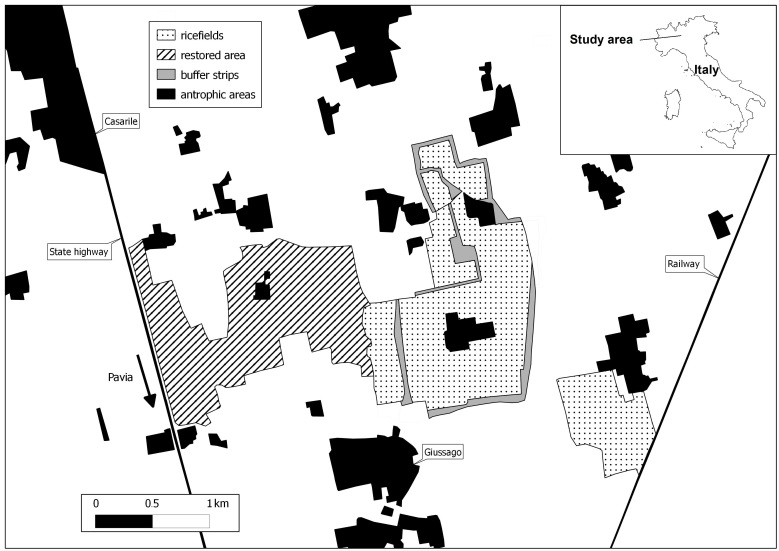
Schematic representation of the study area (anthropic areas include villages, farmsteads, main roads and railways).